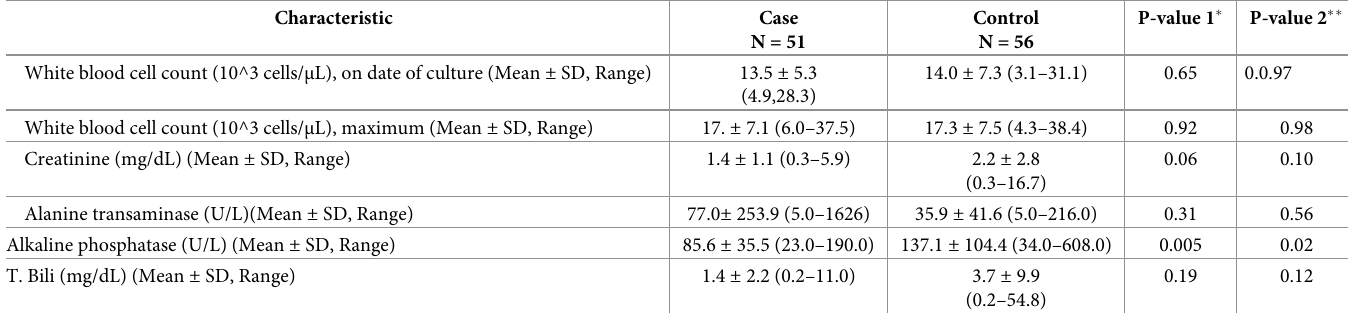
of bacteremia; controls had more positive prior cultures (Table 4).